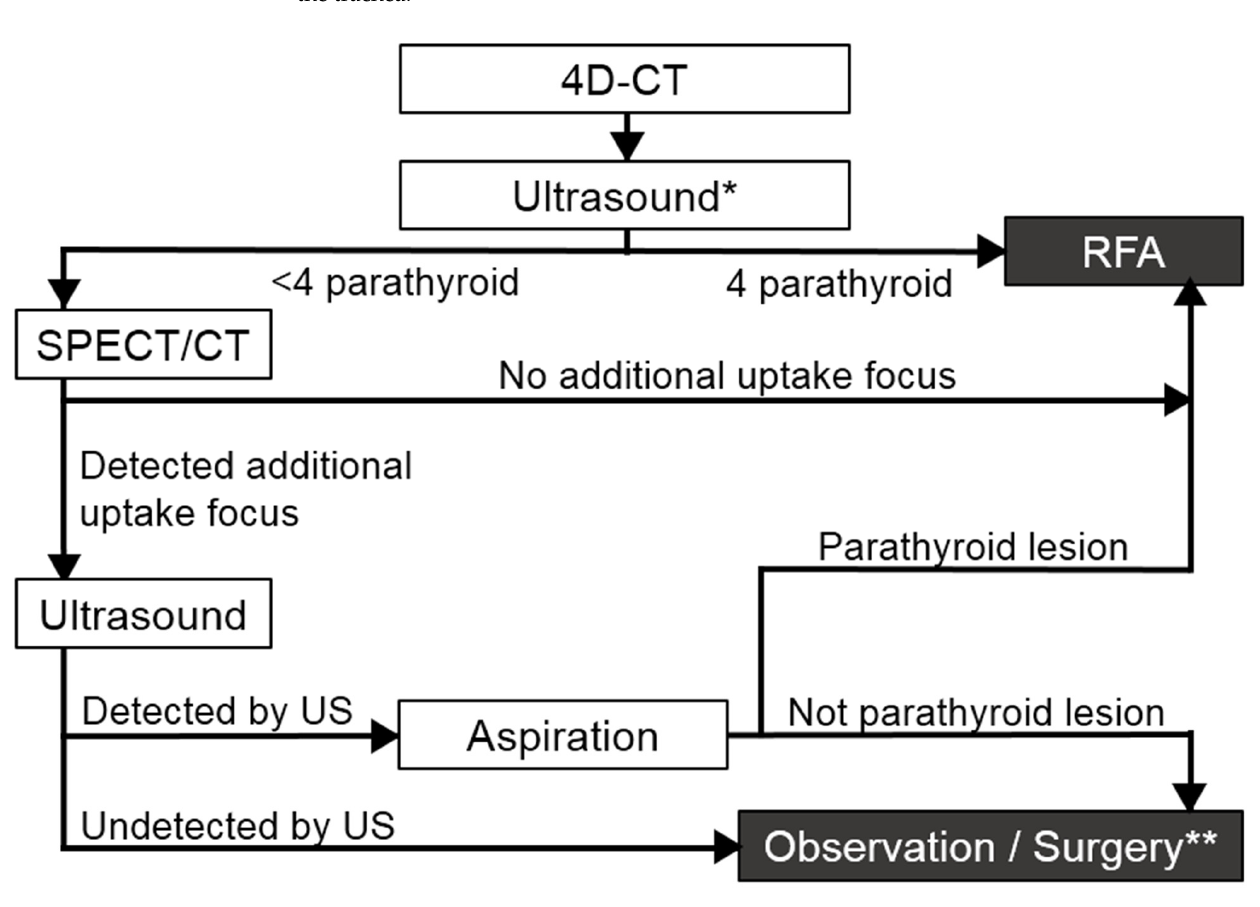
Figure 6. The diagnostic algorithm of localization before radiofrequency ablation for secondary hyperparathyroidism. * Ultrasound-guided tissue aspiration in suspicious lesions with atypical features on 4D-CT or ultrasound. ** Dependent on decision of the patient and clinical doctor.